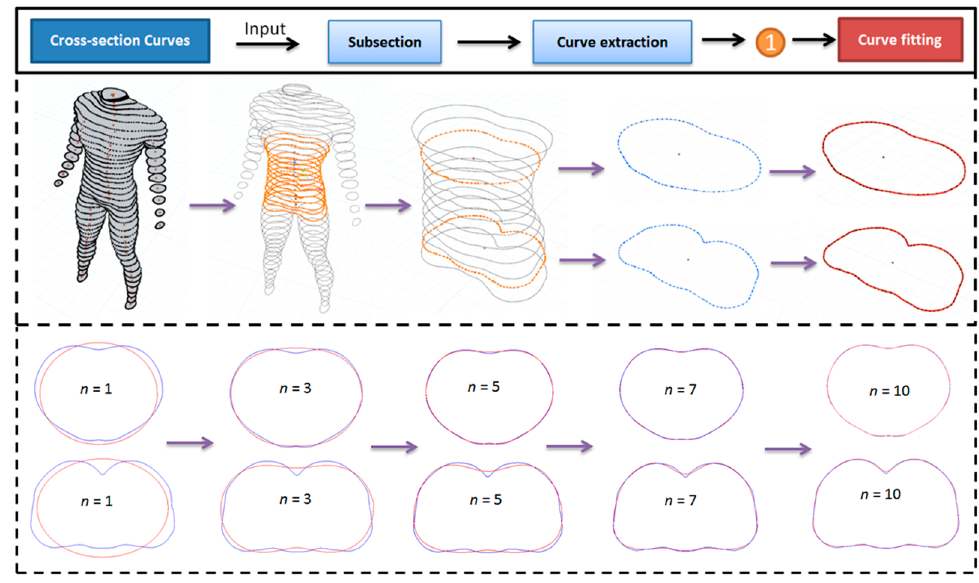
Figure 3. Curve fitting example. The ground truth curves are shown in blue and fitted generalized elliptic curves are in red.